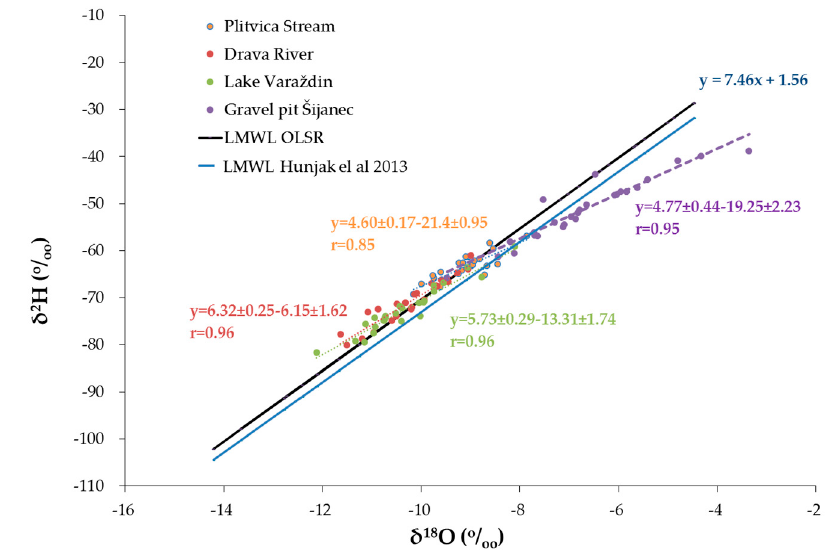
Figure 6. Distribution of surface waters δ 18 Ο ( o / oo ) and δ 2 H ( o / oo ) values around the LMWL.